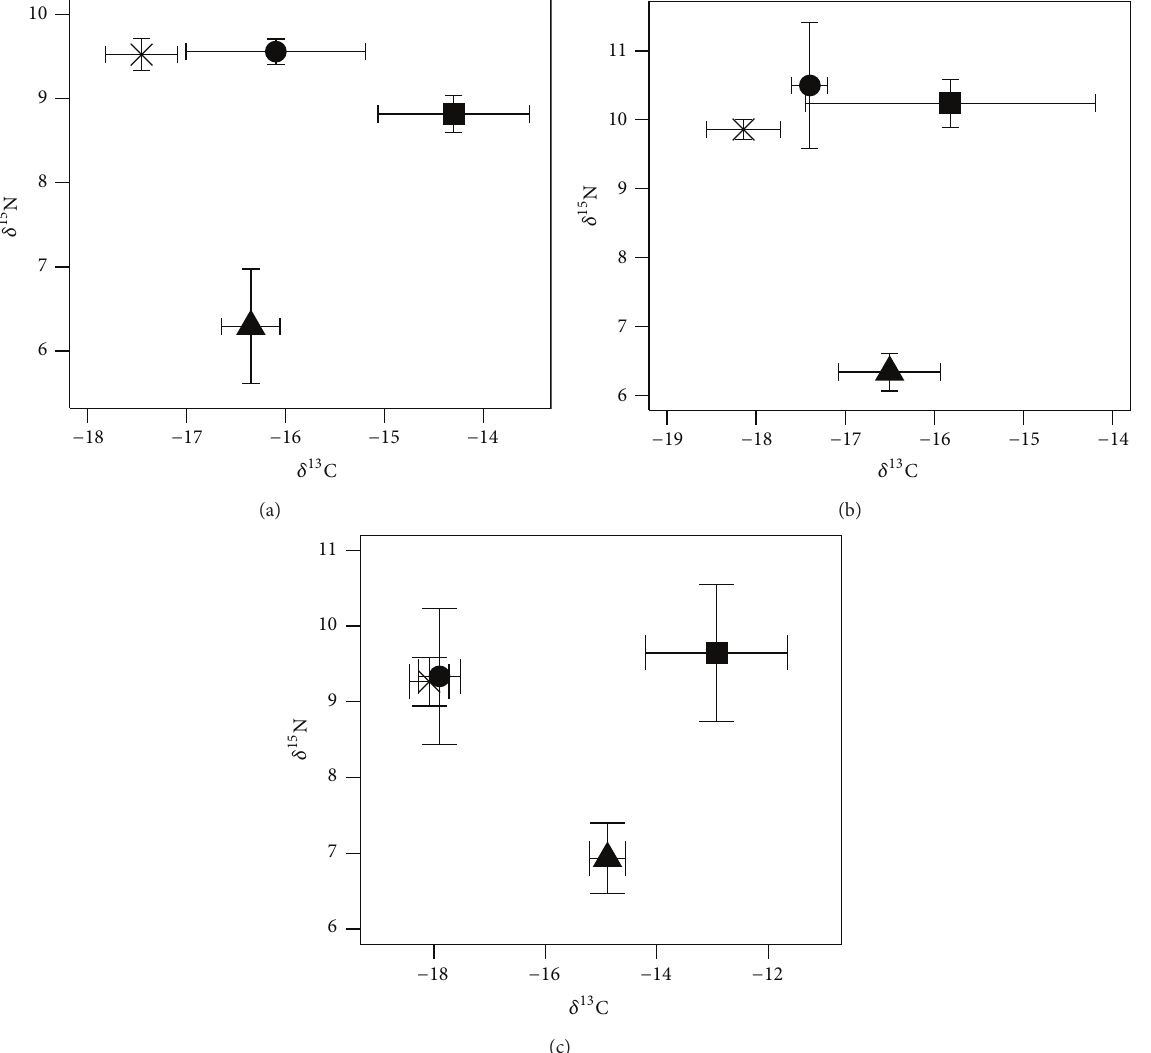
Figure 2: Mean 𝛿 13 C and 𝛿 15 N ratios of prey and predator species from Nabeta (a), Shirahama (b), and Suzaki (c) ( 𝑛 = 5 per each species). Triangle = S. virgatus in Nabeta (a) and Shirahama (b) and A. senhousia in Suzaki (c); × = Capitulum mitella ; circle = Tetraclita japonica ; and square = Reishia clavigera . Error bars indicate 1 standard